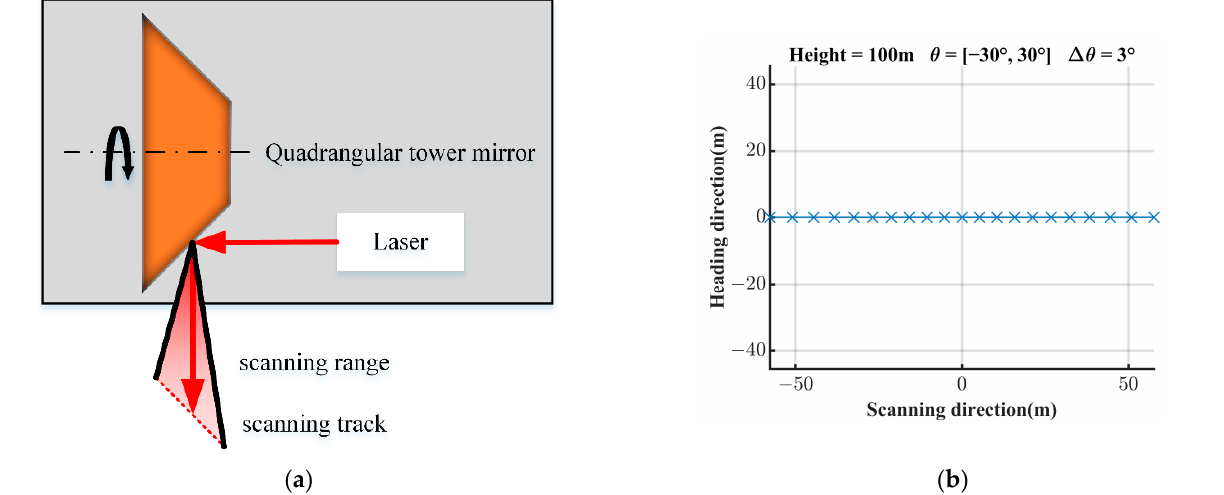
Figure 7. Quadrangular tower mirror scanning mode 2. ( a ) Scanning schematic diagram; ( b ) Scan- ning track with a height of 100 m, a motor rotation angle of ±30° , and an interval angle of 3° be- tween points.